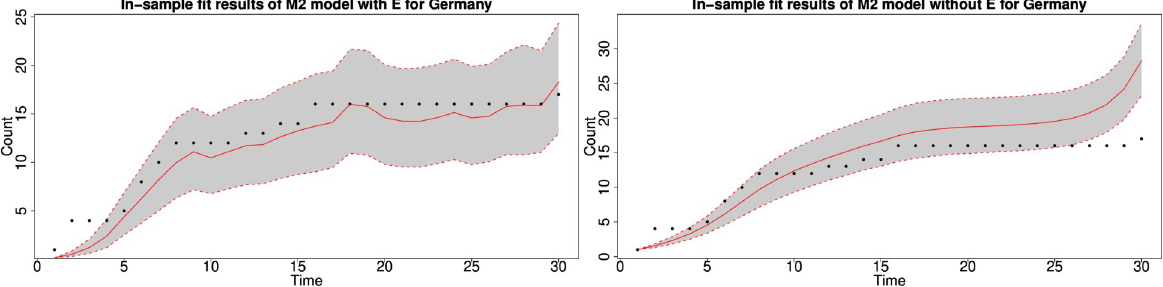
Fig 20. In-sample fit results with the sentiment exposure adjustment for Germany. In-sample fitting plot for Germany by Model 2 for the first month with (left) and without (right) the sentiment exposure adjustment.